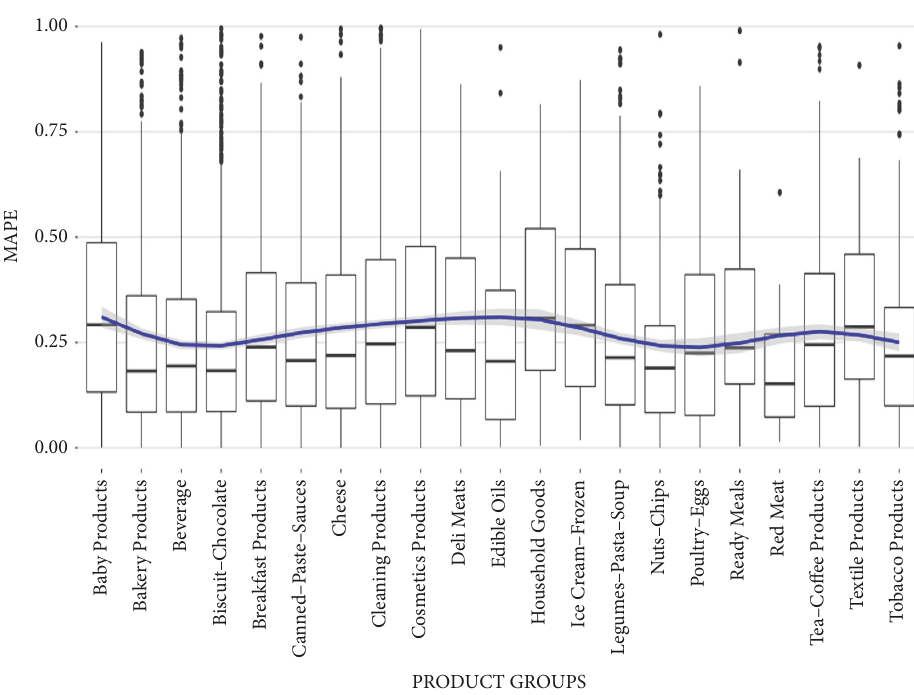
Figure 3: MAPE distribution according to product groups with S 2 integration strategy.